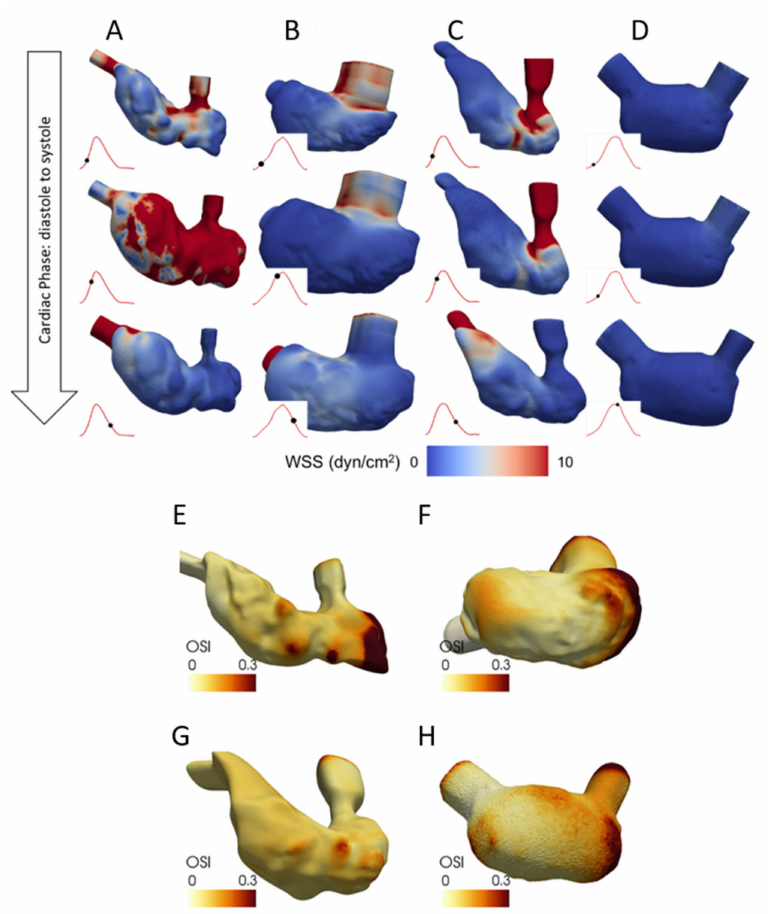
Figure 5. WSS patterns at various instants over the cardiac cycle. ( A ) Normal embryo. ( B ) Inhibited trabeculation. ( C ) Inhibited proliferation. ( D ) Inhibited ventricle development. Red line and black dot represent the instant over the cardiac cycle. OSI patterns are determined using three cardiac cycles. ( E ) OSI pattern of the normal embryo. ( F ) OSI pattern for inhibited trabeculation. ( G ) OSI pattern for inhibited proliferation. ( H ) OSI pattern for inhibited ventricle development (Reproduced from Vedula et al. (2017)